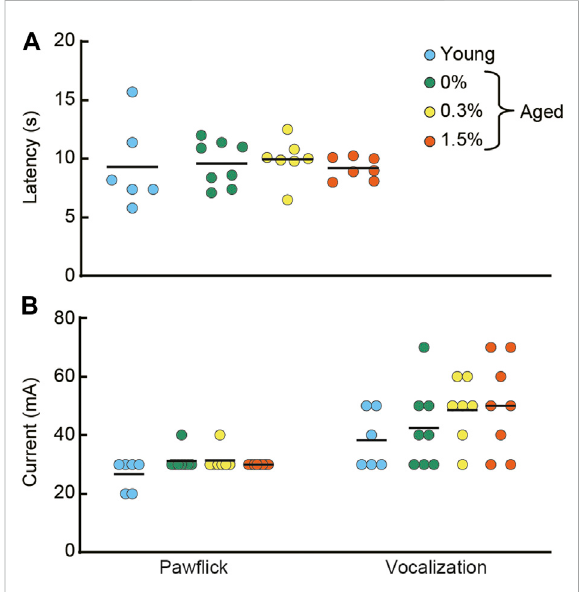
FIGURE 7 Cilostazol has no effect on pain sensitivity. After the completion of the fear conditioning task, half of the mice from each group were tested in hotplate test and the electrical footshock sensitivity test. (A) Scatter dot plot representing latency to lick a forepaw. One-way ANOVA showed that the aged mice receiving 0.3 or 1.5% cilostazol performed similarly to the aged control (0% cilostazol) mice. (B) Scatter dot plot of electric current intensity to evoke a paw fl ick and vocalization. One-way ANOVA revealed no statistical signi fi cance among the three groups of aged mice. These results from the two analgesia tests show that 1 month of cilostazol has no apparent effect on pain sensitivity, regardless of the type of noxious stimuli. In the graph, 0%, 0.3%, and 1.5% represent the concentration of orally administered cilostazol. Data for young mice (Young) are for reference only; they were not included in statistical analyses. Horizontal bars indicate mean